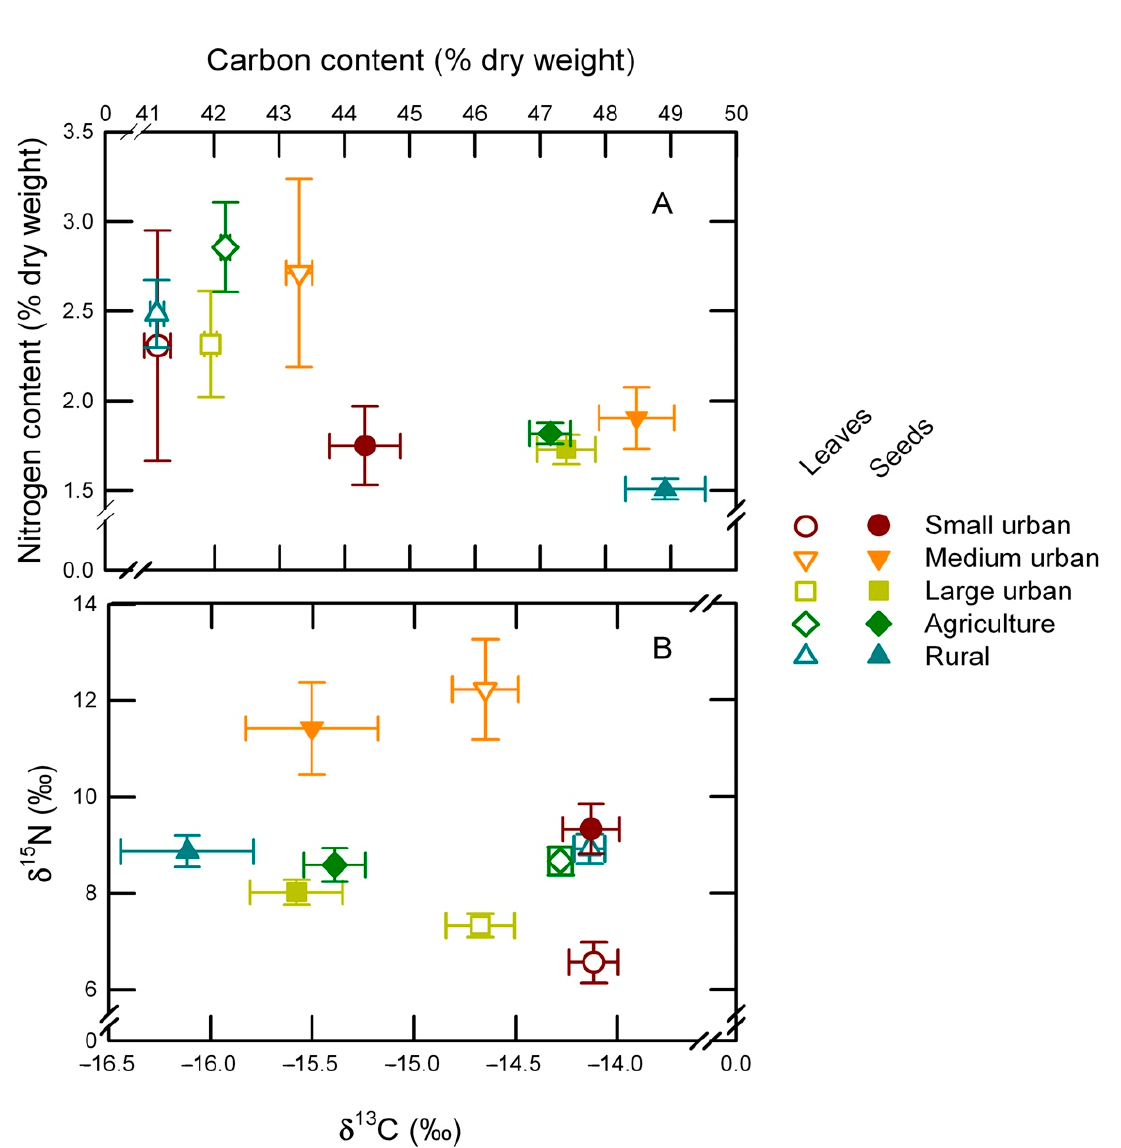
Figure 4. Elemental and isotopic carbon and nitrogen composition for leaves and seeds of C. ciliaris collected from sites with different land use. ( A ) Carbon and nitrogen content (dry mass basis) for leaves (open symbols) and seeds (closed symbols) collected from small (circles), medium (inverted triangles), and large cities (squares), agricultural lands (diamonds), and rural sites (triangles). ( B ) Carbon and nitrogen isotopic signatures for leaves and seeds of C. ciliaris collected from sites with different land use. Data are shown as mean ± S.E. See underlying data in Appendix A.